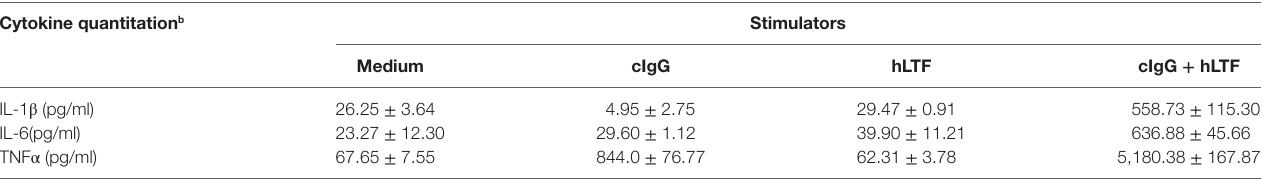
Table 2 | Cross-talk between Fc γ R and LTF-R in human M2 macrophages. a cytokine quantitation b